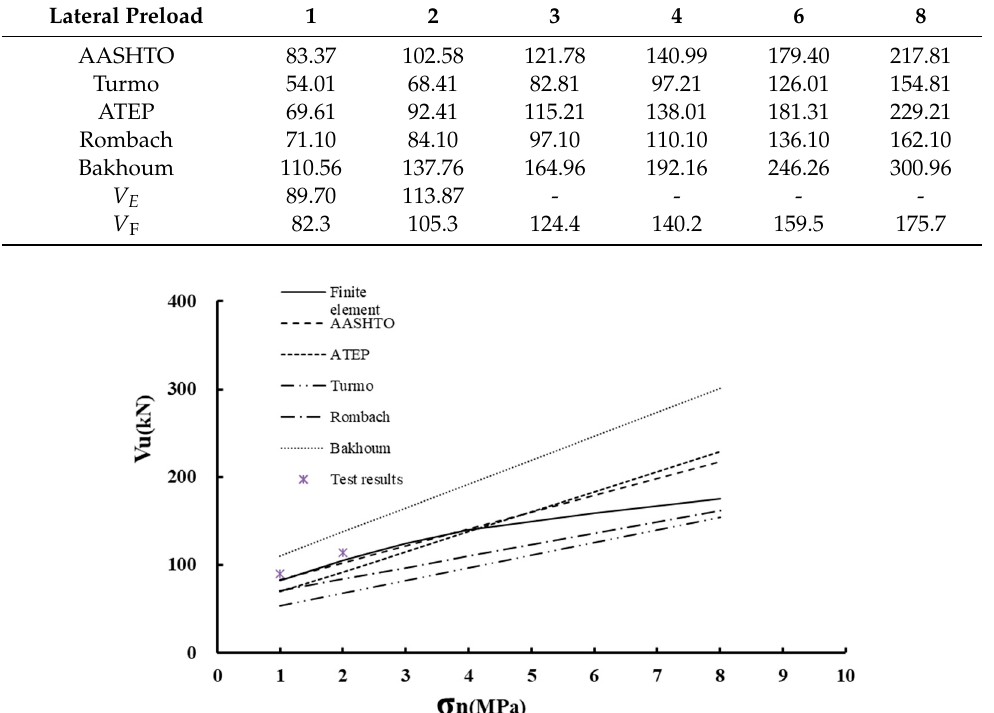
ff erent lateral prestress.